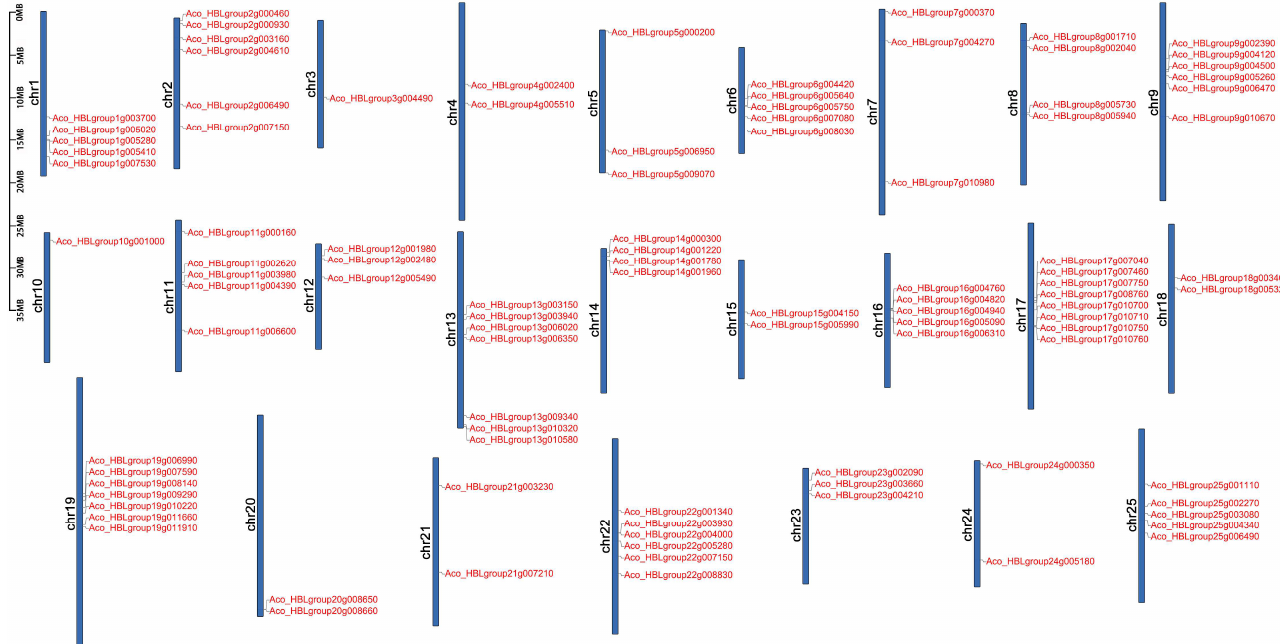
Figure 3. Chromosomal locations and distribution of AbR2R3-MYB genes. There are 25 chromosomes (Chr1-Chr25) in A. comosus var. bracteatus . Gene positions and chromosome length were measured using the scale on the left in megabases (Mb).